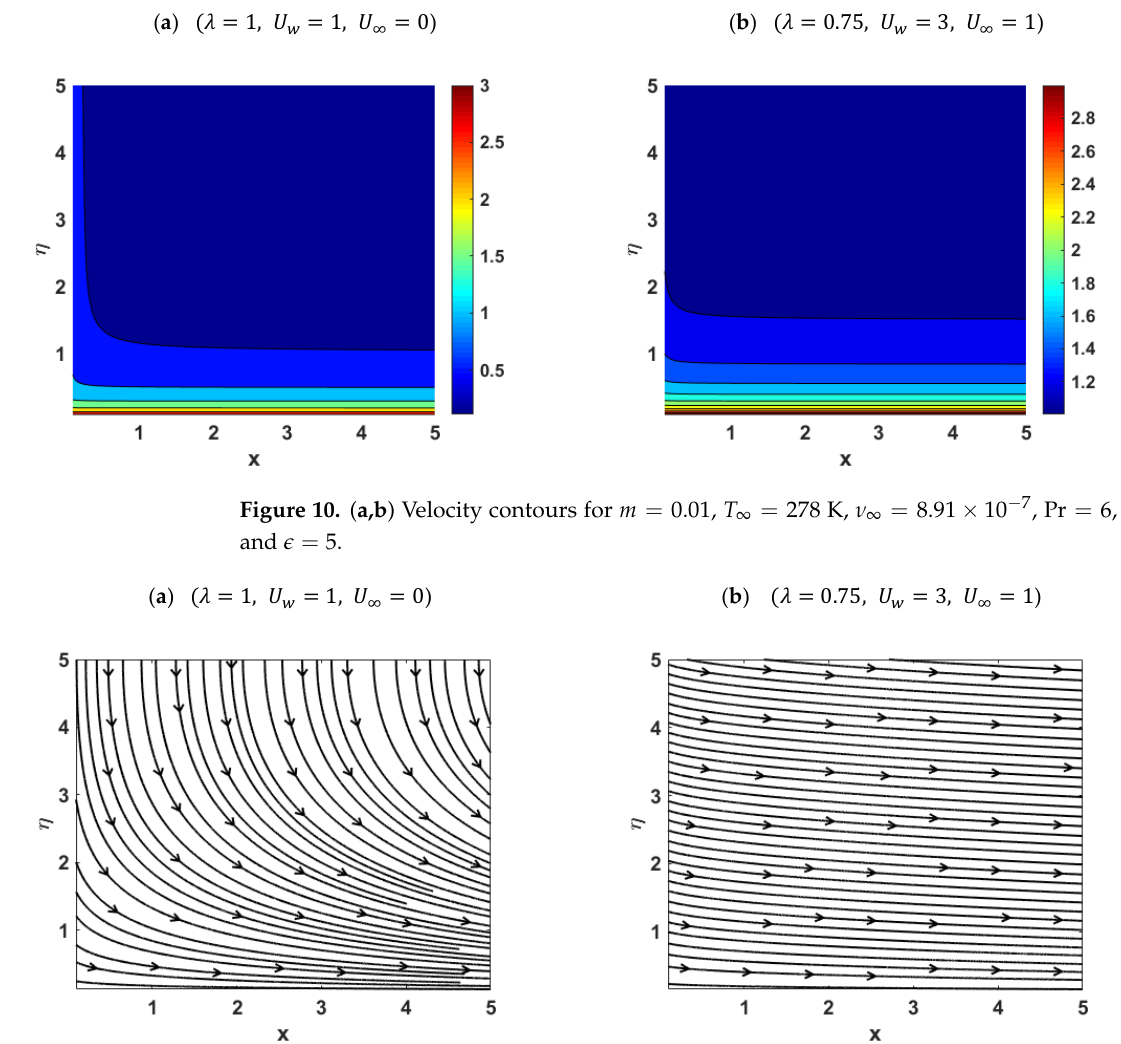
Figure 9. Graphical representation of 𝑓 (cid:4593) ′(cid:4666) 0.1 (cid:4667) and 𝜃(cid:4666) 0.1 (cid:4667) for different choices of the parameter 𝑃𝑟 when 𝑚 (cid:3404) 0.1 , 𝜆 (cid:3404) 0.3 and 𝜃 (cid:3050) (cid:3404) 1.27 . Part ( a ) shows function 𝑓′ , while the function 𝜃 is plotted in part ( b ).